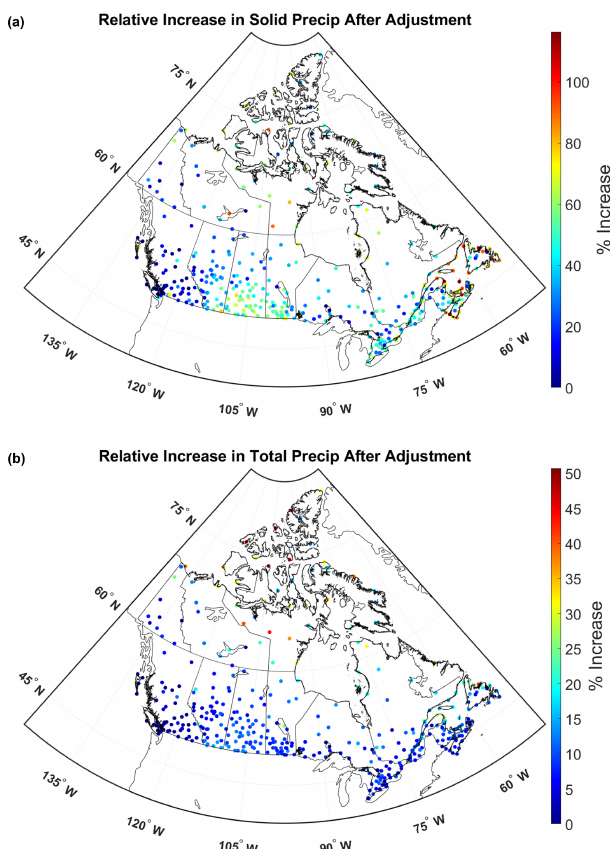
Figure 6. Relative increase in station solid precipitation (a) and to- tal precipitation (b) , following the adjustment for wind bias using the WMO-SPICE UTF for the entire station record following au-